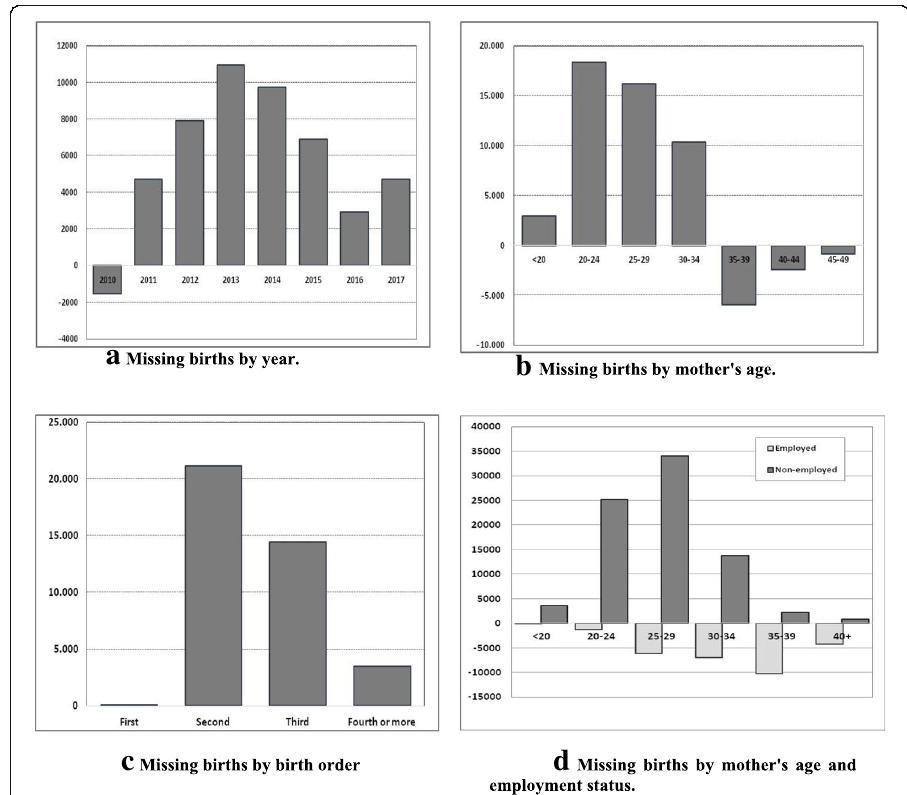
Fig. 7 a Missing births by year. b . Missing births by mother ’ s age. c . Missing births by birth order. d . Missing births by mother ’ s age and employment status. Missing births are defined as the difference between actual births and those expected if pre-recession age-specific fertility rates had remained unchanged. Missing births = Expected − Actual births. A positive sign indicates a reduction in births; a negative sign indicates that fertility rates and thus the number of registered births is higher than